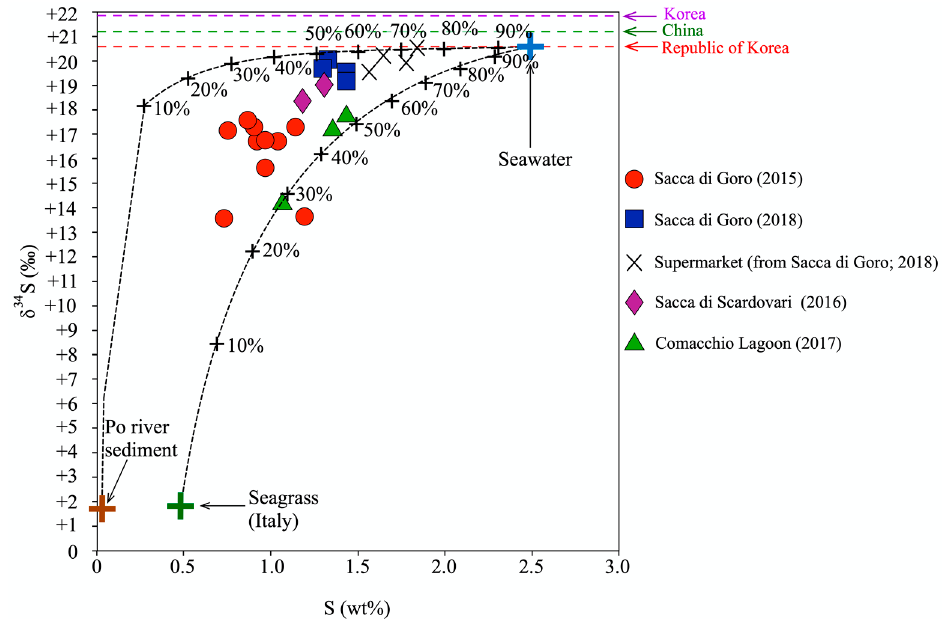
Figure 4. Sulfur (S) content vs. δ 34 S of tissues of manila clams collected on-site from northern Adriatic lagoons and bought at a local supermarket. The elemental and isotopic values of S for seawater are from Adriatic marine plankton of Giani et al. [54] and Borrell et al. [55], respectively. The values for Po River sediments are from Salani et al. [56], and for seagrass, they are from Holmer and Nasler-Sheetal [57]. Tick marks on the seawater–riverine mixing lines indicate the contribution of seawater. The average δ 34 S values from China, Democratic People’s Republic of Korea (DPR), and Korea from the study of Won et al. [11] are also represented for a comparison. The analytical uncertainties are negligible at the graphical scale.